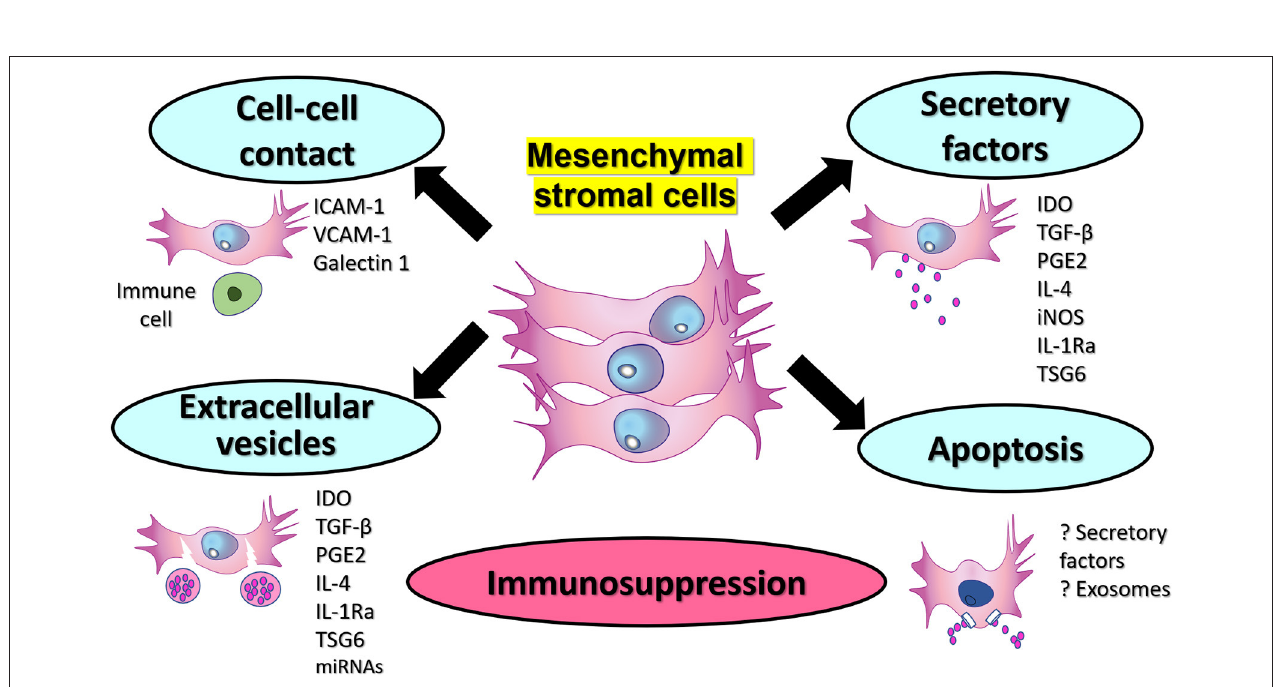
FIGURE 2 | Potential mechanisms of immunosuppression by therapeutic MSCs. Therapeutic MSCs could display immunosuppression via production of extracellular soluble factors. Cell to cell interactions between MSCs and immune cells can be mediated via surface molecules such as ICAM-1, VCAM-1, and Gelactin-1. Additionally, extracellular vesicles containing immunosuppressive factors and other proteins and miRNAs constitute another mechanism that could be used therapeutic for autoimmune diseases. Finally, apoptotic MSCs that can be engulfed by macrophages, and this could probably help to mediate immunosuppression via soluble factors or extracellular vesicles or